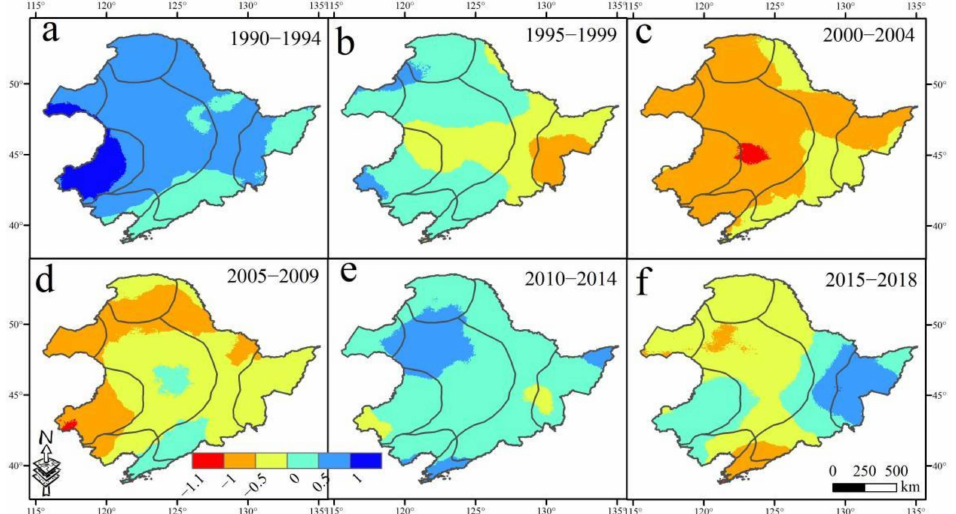
Figure 2. Maps of dry–wet conditions in northeast China (NEC) from 1990 to 2018 every five